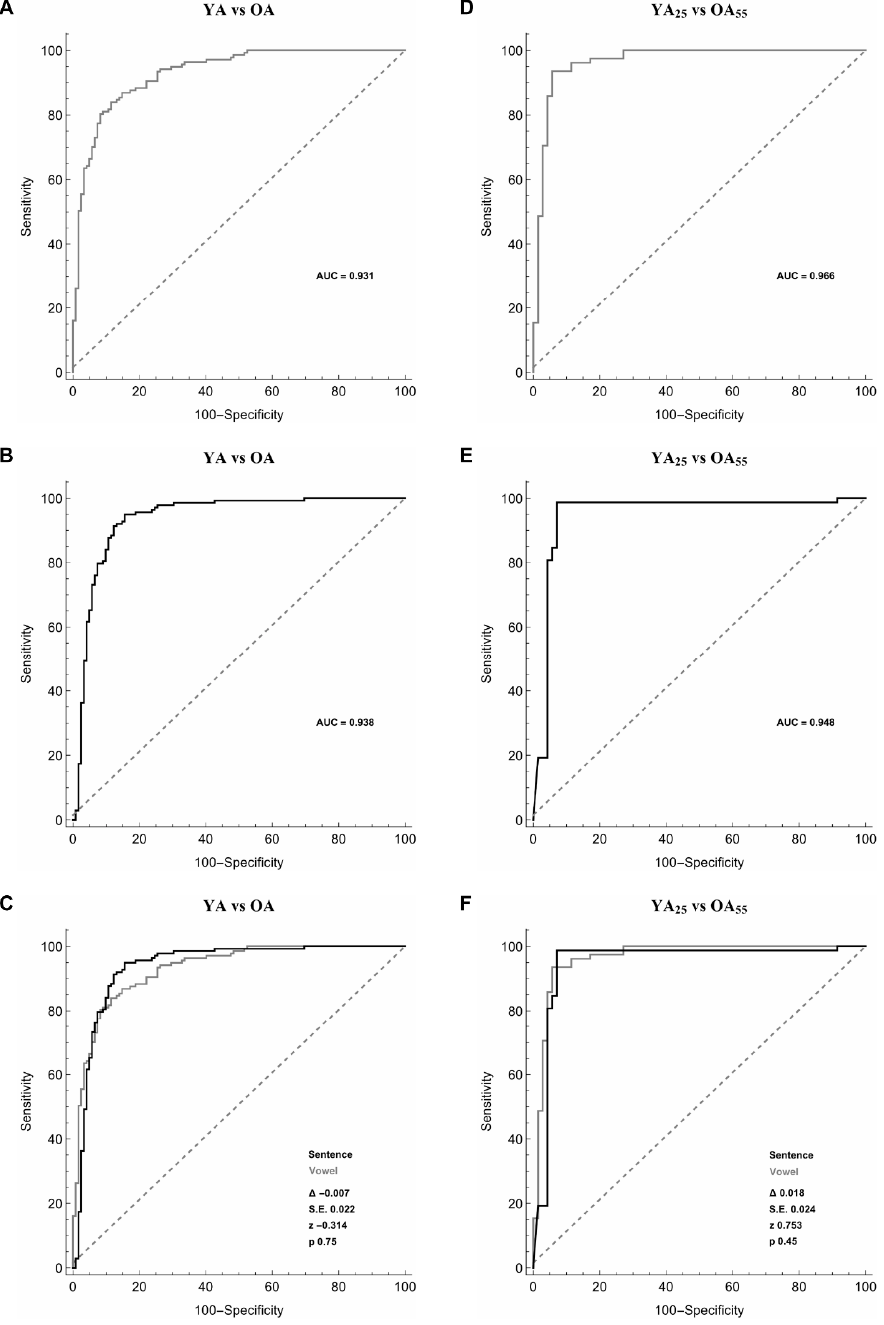
Figure 2. Receiver operating characteristic (ROC) curves used to di ff erentiate younger adults (YA) vs. older adults (OA) (left column, panels ( A – C )) and younger adults ≤ 25 years (YA 25 ) vs. older adults ≥ 55 years (OA 55 ) (right column, panels ( D – F )) during the sustained emission of a vowel (grey line) (panels ( A , D )), the sentence (black line) (panels ( B , E )) and the comparison between the vowel and the sentence (panels ( C , F )).